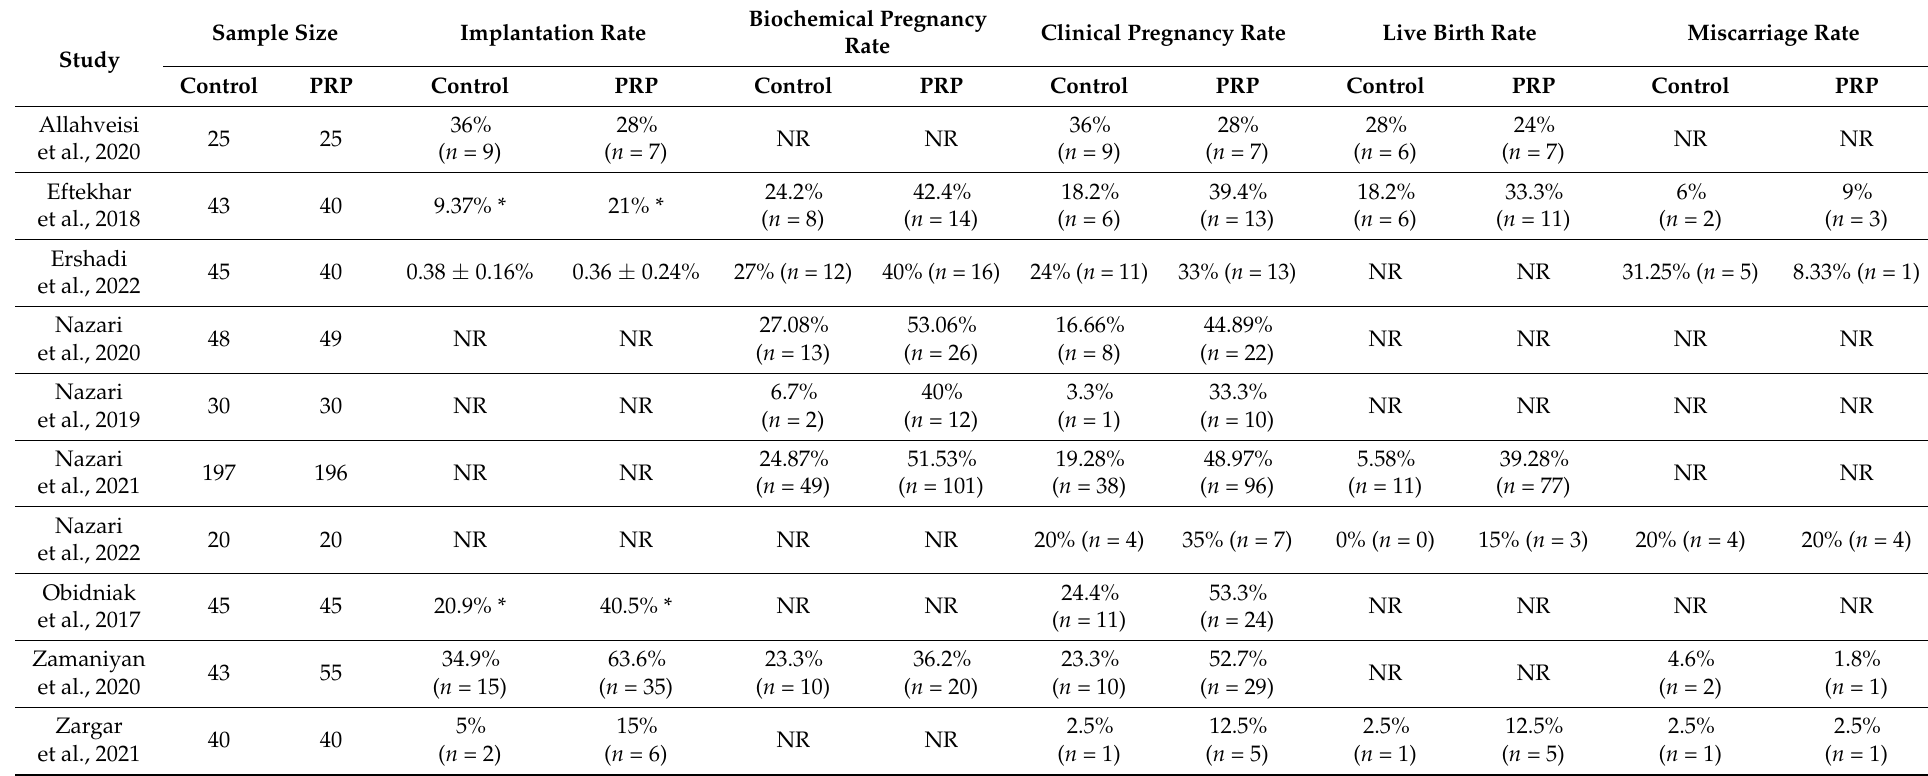
Table 2. Outcomes of the selected